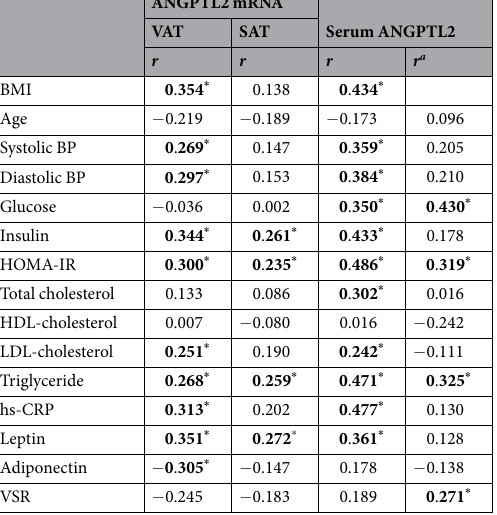
Table 2. Correlations between metabolic parameters and adipose tissue ANGPTL2 mRNA or serum ANGPTL2 in study participants. n = 77, r = Pearson correlation coefficient; r a = Correlation coefficient after adjustment for BMI; * P < 0.05.